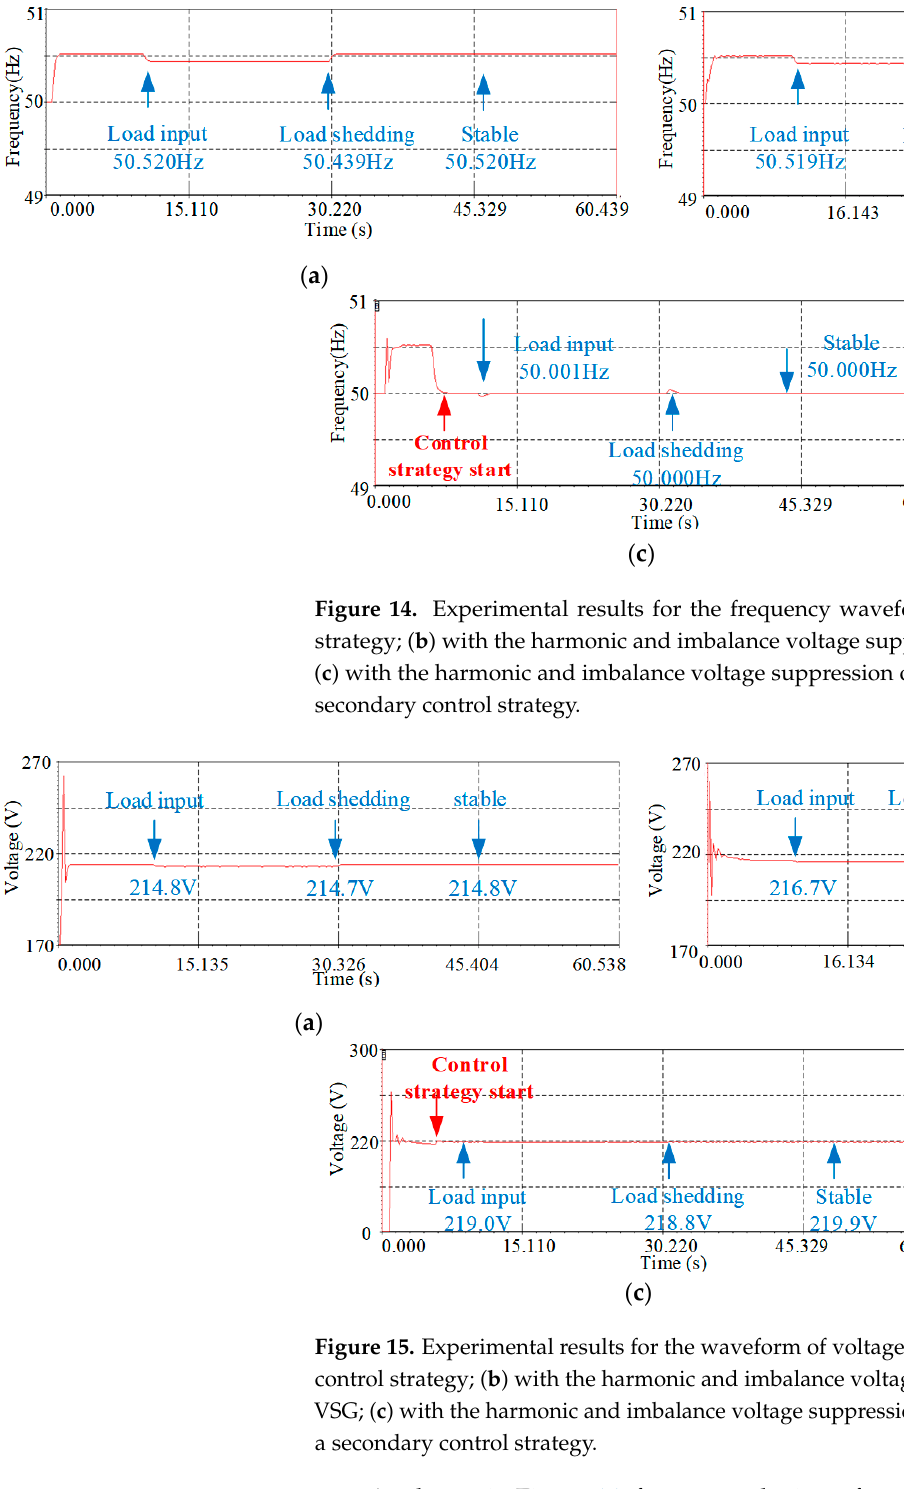
( b ) Figure 16. Experimental results for the voltage waveform of microgrid for PCC point ( a ) without the imbalance voltage suppression of multi-inverter parallel VSG adding a secondary control strat- egy; ( b ) with the harmonic and imbalance voltage suppression of multi-inverter parallel VSG add- ing a secondary control strategy. Moreover, in the comparison of the three-phase voltage harmonic imbalance experi- mental waveforms of Figure 16a,b, the result shows that voltage harmonics and imbal- ances are significantly eliminated. From Table 2, the THD of 5th voltage harmonics reduce from 7.1% to 0.11%, the THD of 7th voltage harmonics reduce from 4.6% to 0.08%, and the imbalance ratio of voltage reduces from 5.61 to 0. It fully demonstrates that the control method proposed in this pa- per has significant control effects on harmonics and imbalance suppression. The results of the frequency and the RMS of voltage indicate the effectiveness of the proposed secondary control strategy. In addition, compared with the traditional PI control and droop control, the harmonic and imbalance voltage suppression of multi-inverter parallel VSG proposed